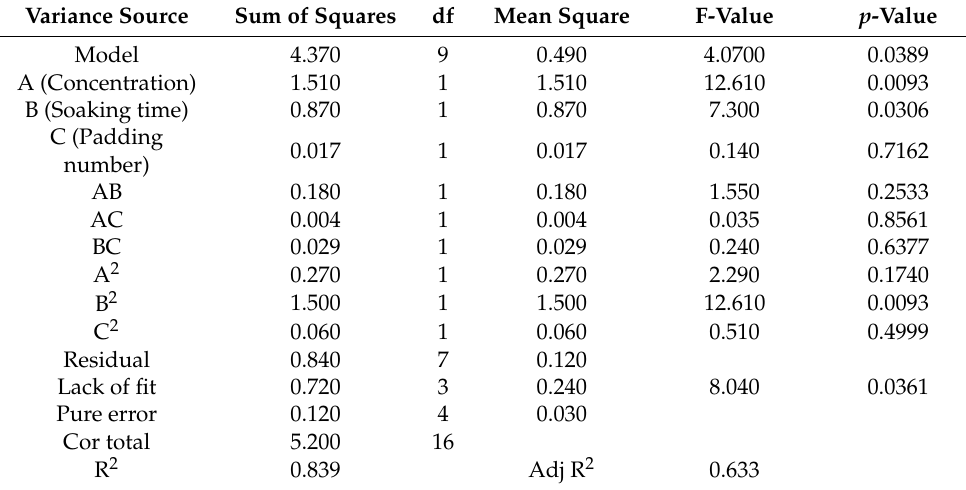
Table 2. ANOVA results for breaking strength.